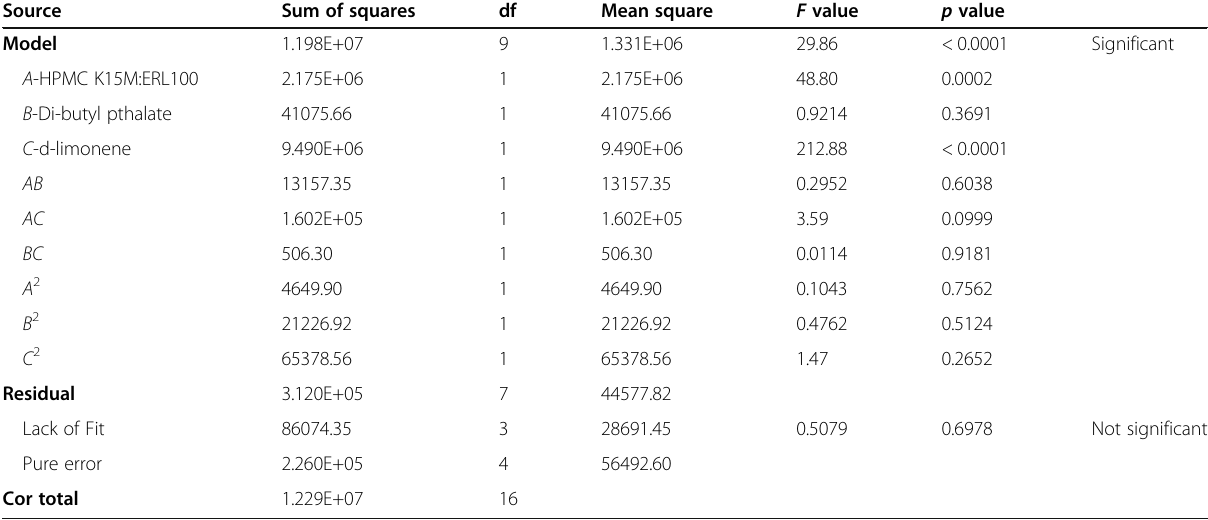
Table 6 ANOVA for the quadratic model {cumulative amount of drug permeated in 24 h ( Q 24 ) response}